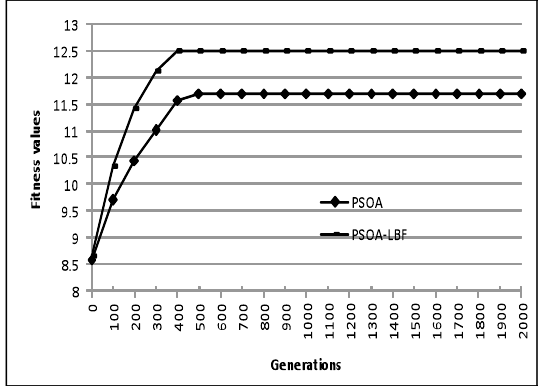
Fig.8 Fitness comparisons for LBF